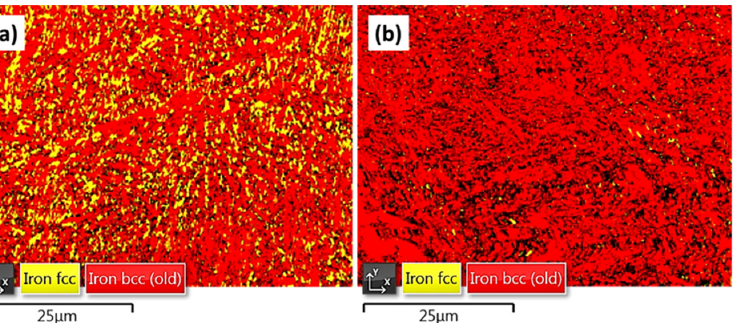
Figure 7. The standard 1.2343 as-built: ( a ) Retained austenite (Ra)—18%. Preheated treatment (500 °C). ( b ) Preheated treatment (500 °C): Retained austenite (Ra)—1.1%. Faster cooling rates in the LPBF process will lead to a higher amount of RA in the built parts.